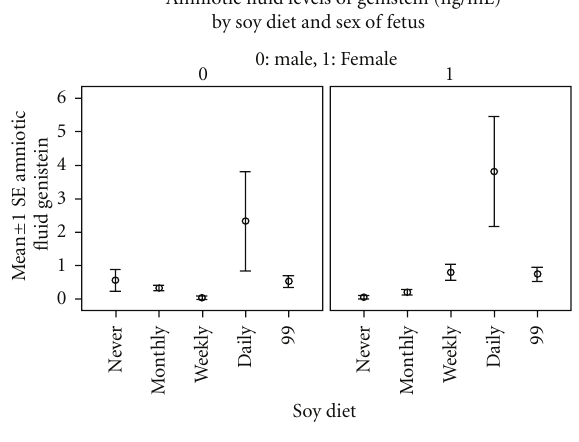
Figure 4: The amniotic fluid levels of Genistein (ng/mL) by soy diet and sex of